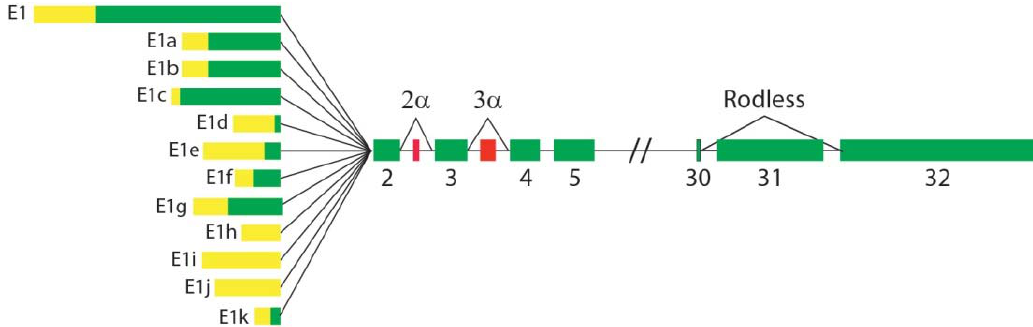
Figure 2. Plectin transcripts generated by alternative splicing. Twelve first exons splicing into exon 2 are shown. Untrans- lated regions (yellow) and coding regions (green) are marked. Two optionally spliced exons, 2 α and 3 α , inserted between exons 2 and 3 and 3 and 4, expressed in some isoforms, are marked in red. Alternative splicing of exon 31 encoding plectin’s rod domain generates the rodless isoform. The figure is not drawn to scale.